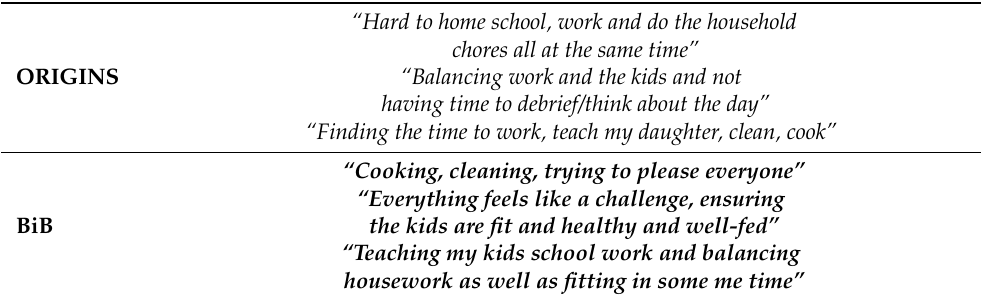
Table 6. Tasks and responsibilities: Sample